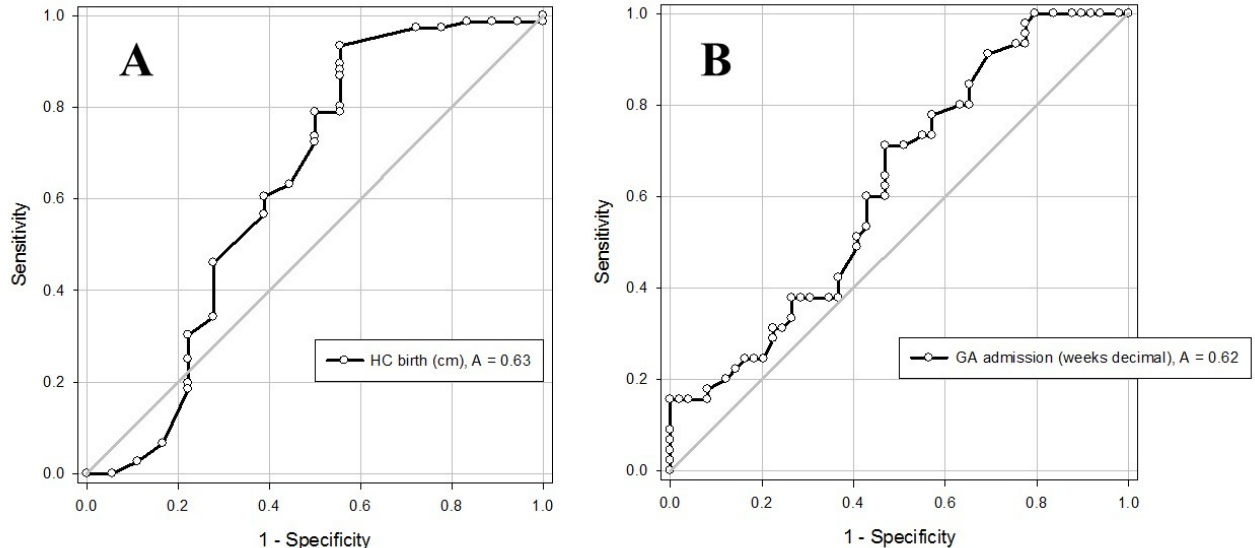
Figure 1. ROC Curves and cut-off values to identify infants who are likely to require central line. ( A ) By dominant IV line (0 = peripheral, 1 = central): Area under curve (AUC) of ROC for head circumference (HC) at birth (in centimeters) = 0.63 (95% confidence interval (CI) 0.46–0.81. Using HC cutoff > 29 cm (~the 50% percentile at ~32 weeks’ gestation) the sensitivity is 0.89 (95% CI 0.80–0.95) and the specificity is 0.44 (95% CI 0.21–0.69). ( B ) By need for two or more IV lines during hospitalization: AUC of ROC for gestational age (GA) upon admission to the NICU (in weeks) = 0.62 (95% CI 0.51–0.74). Using GA cutoff at birth > 32 weeks the sensitivity is 0.98 (95% CI 0.88–1.00) and the specificity is 0.22 (95% CI